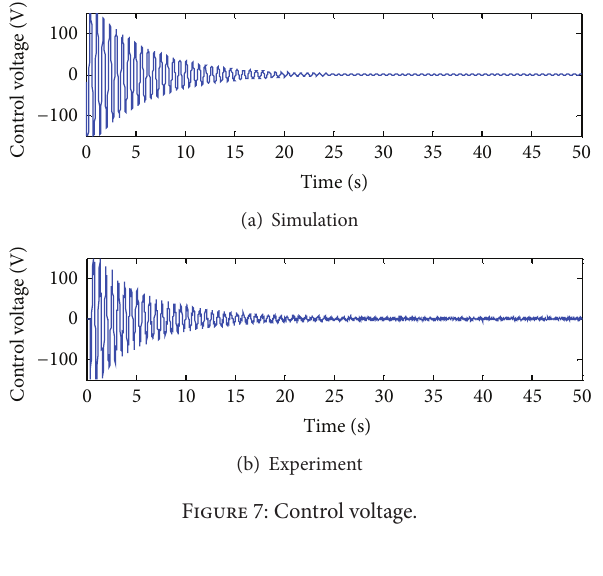
Figure 7: Control voltage.